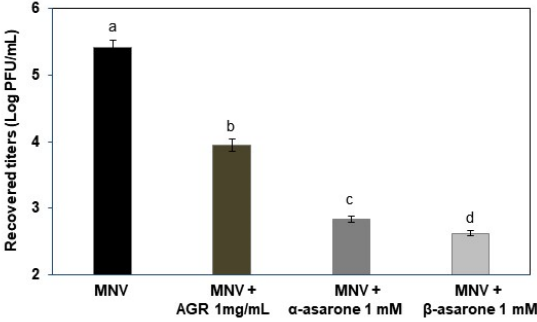
Figure 5. Recovered titers of MNV after treatment with AGR extract, α -asarone, or β -asarone under simulated digestive conditions. MNV titers were evaluated using plaque assays. Different letters designate significant differences ( p < 0.05).